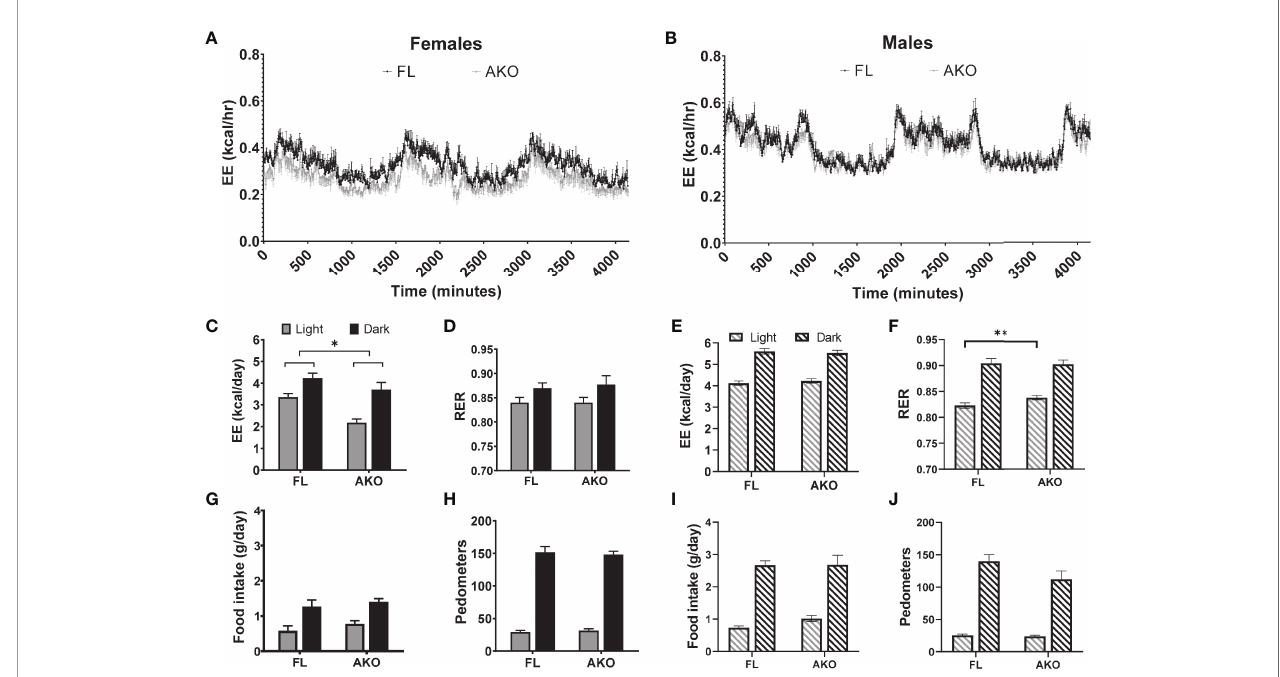
FIGURE 6 | Female, but not male STAT5 AKO mice have reduced energy expenditure. Floxed (FL) and STAT5 AKO (AKO) female (A, C, D, G, H) and male (B, E, F, I, J) mice (10 weeks of age) were individually housed in metabolic cages where oxygen and carbon dioxide concentration were continuously monitored for 3 days. (A, B, C, E) Total energy expenditure (EE) was calculated by multiplying the daily average rate of energy expenditure by 24 and by the number of experiment days. As an estimate of substrate oxidation, (D, F) respiratory exchange ratio (RER, VCO2/VO2), (G, I) food intake and (H, J) total activity in walking meters (pedometers) were measured during the light and dark cycles. Signi fi cance was determined by ANCOVA with fat and fat-free masses as covariates. The * denotes p < 0.05 and **p < 0.01 (n = 8-12/group) between